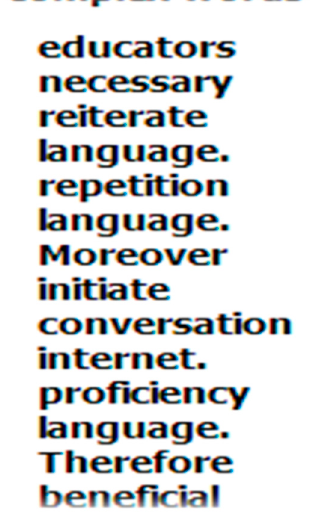
Figure 7. System complex words list view.